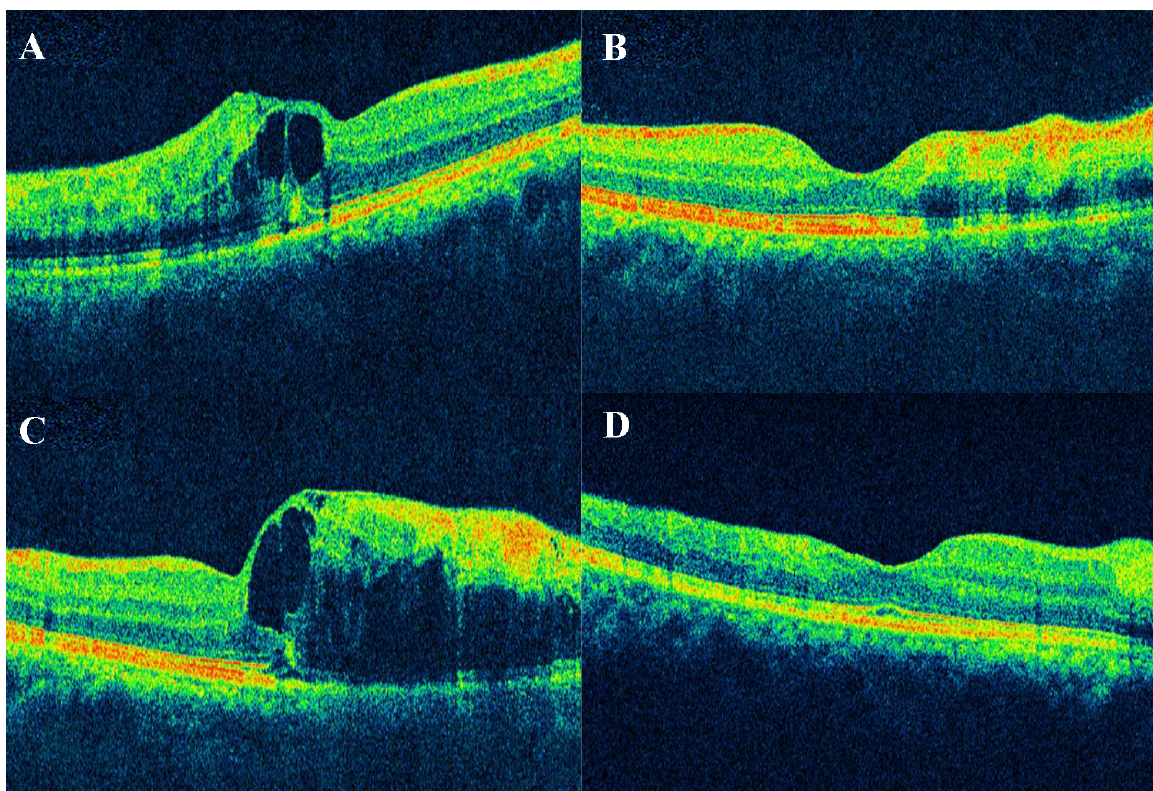
Figure 2: Optical coherence tomography